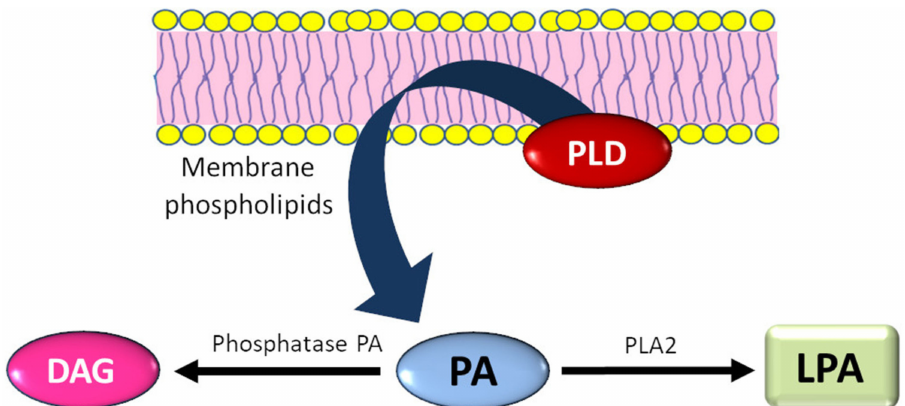
Figure 1. Phospholipase D (PLD)-dependent secondary messenger system. DAG = diacylglycerol, PA = phosphatidic acid, PLA2 = phospholipase A2, LPA = lysophosphatidic